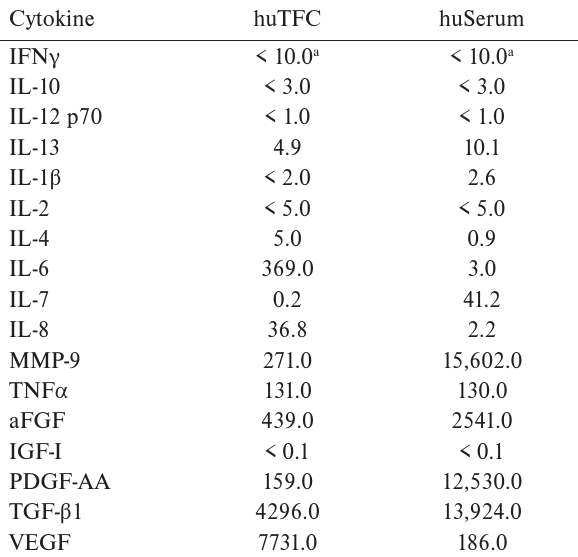
Table 2. Concentrations of selected protein levels in 50-fold concentrated TFC (huTFC) and in human serum (huSerum) from a healthy donor. All values are expressed as pg/ml (ref. 8 ).